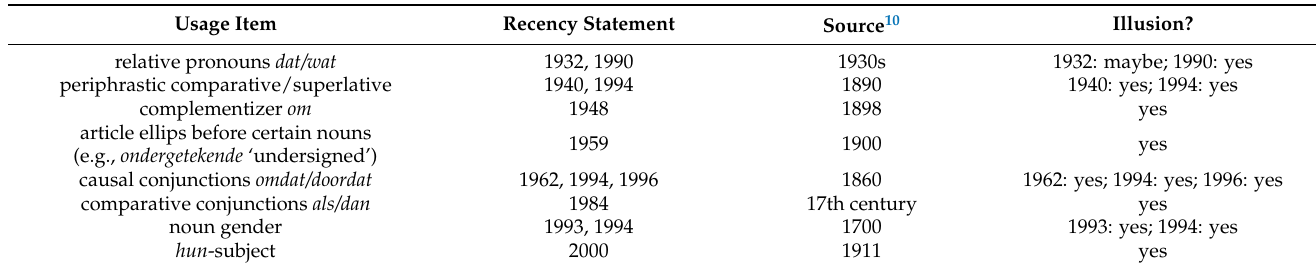
Table 7. Grammatical usage items with year(s) of prescriptive utterance, earliest occurrence in usage, and evaluation with regard to Recency